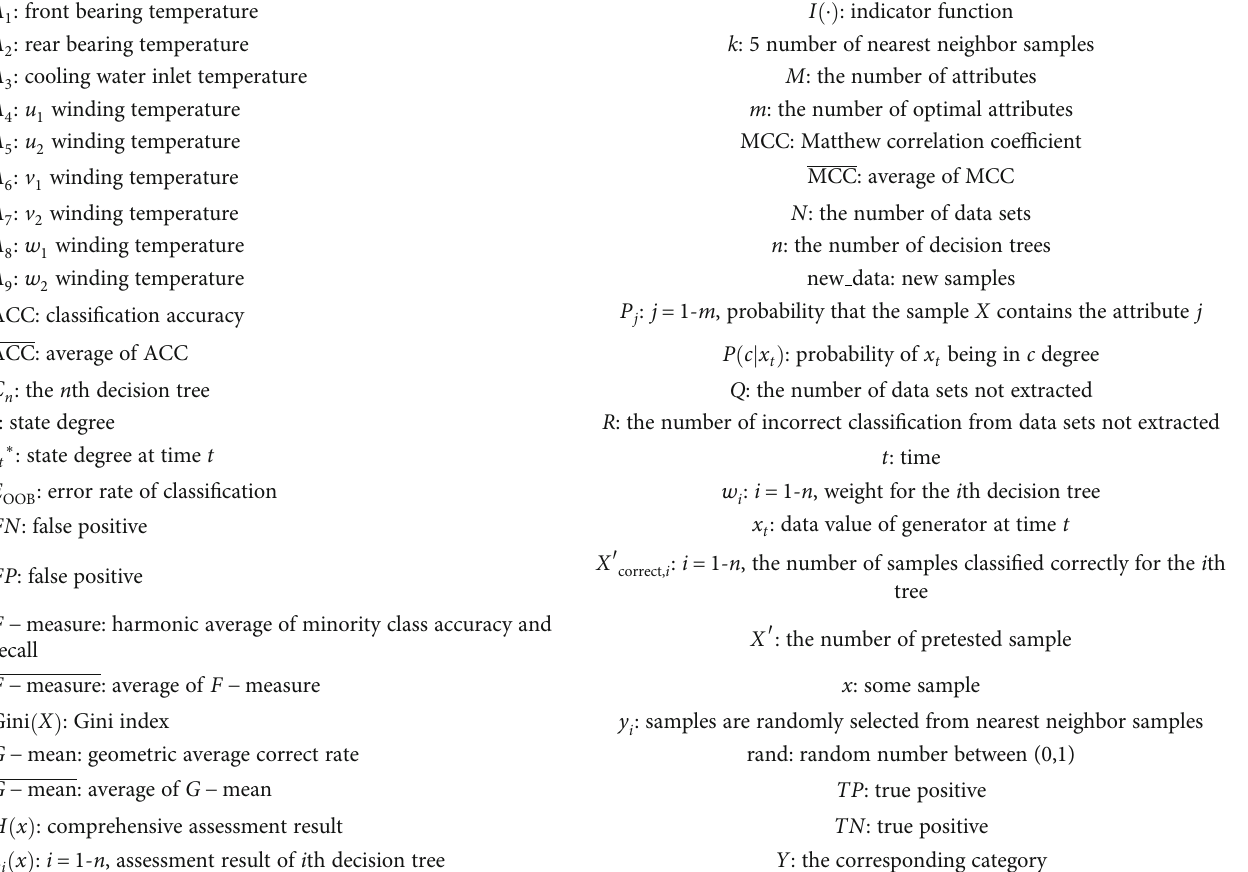
Table 6: De fi nition of all the symbols used in the